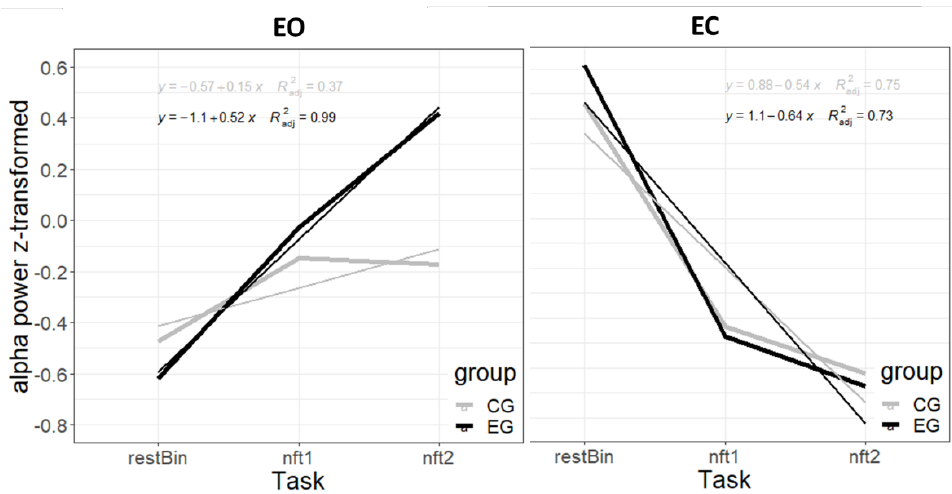
Figure 5. Z-transformed EEG power at intervention blocks. Alpha z-transformed power over the baseline (restBin) and NFT tasks for EO condition and EC at intervention blocks (nft1 and nft2). Three regression slopes are presented separately for CG and EG. Additionally, the regression equations are depicted as well as the regression lines for each group are indicated by thinner lines. The regression slopes at intervention blocks show a significant alpha increase for the EG in the EO condition. In contrast, the EC condition shows a similar downregulation of alpha in both groups.